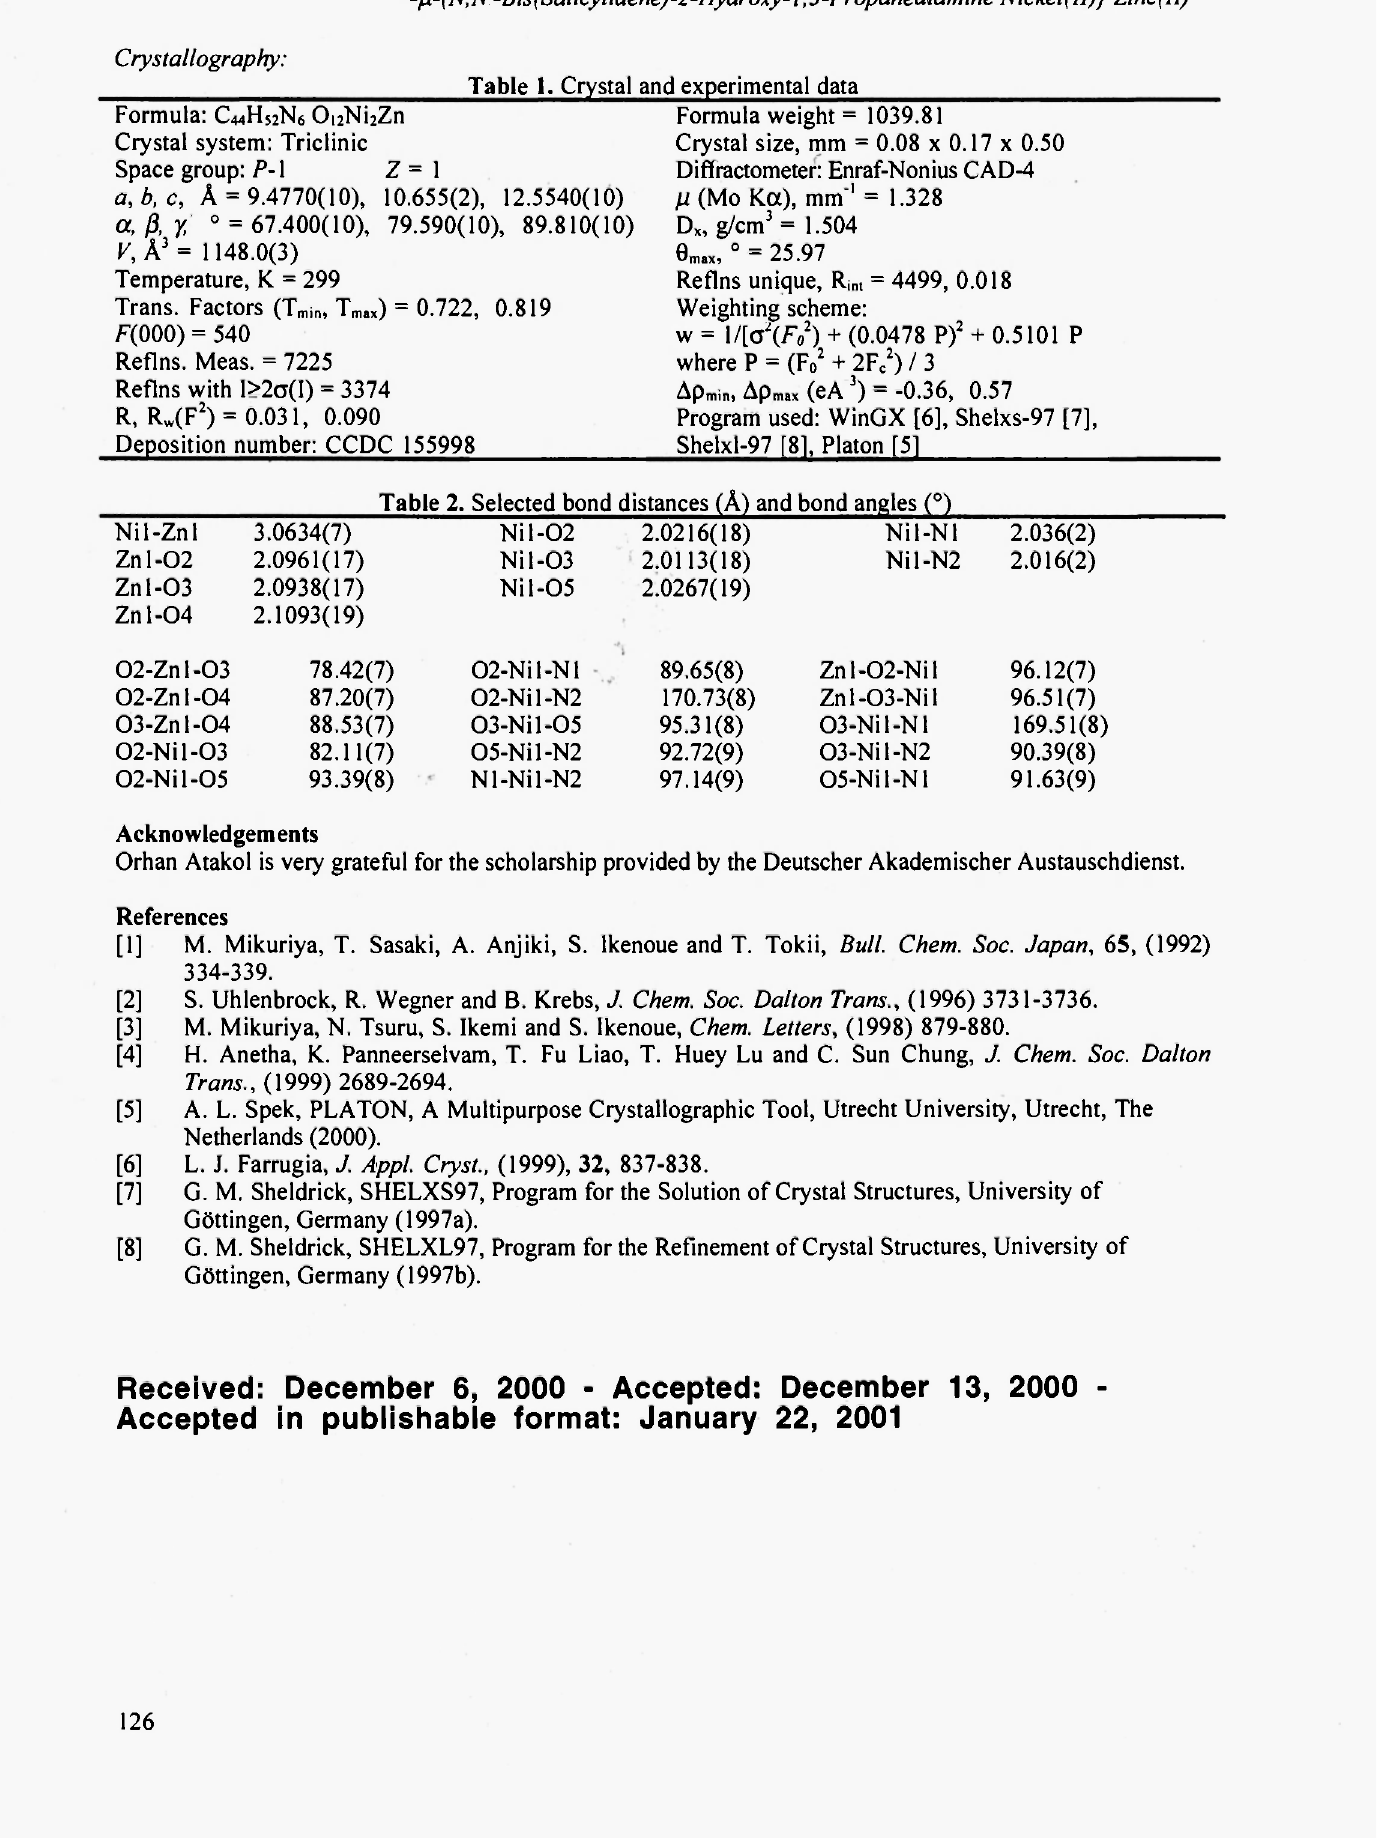
Table 1. Crystal and experimental data